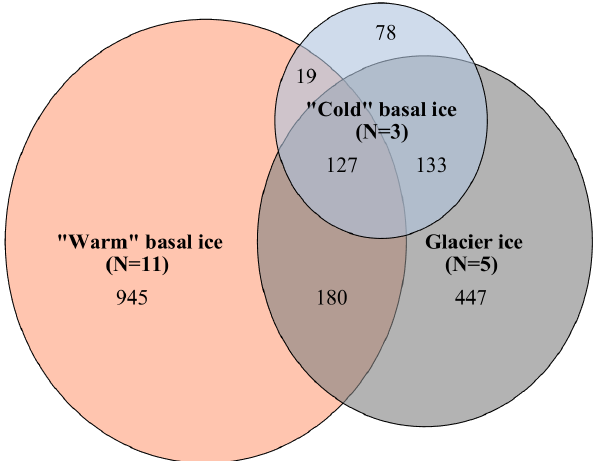
Figure 4. Venn diagrams showing overlap in membership between the microbial assemblages observed in warm basal ice, glacier ice, and cold basal ice samples. Numbers represent the number of oper- ational taxonomic units (OTUs) that are unique to each environment or shared between